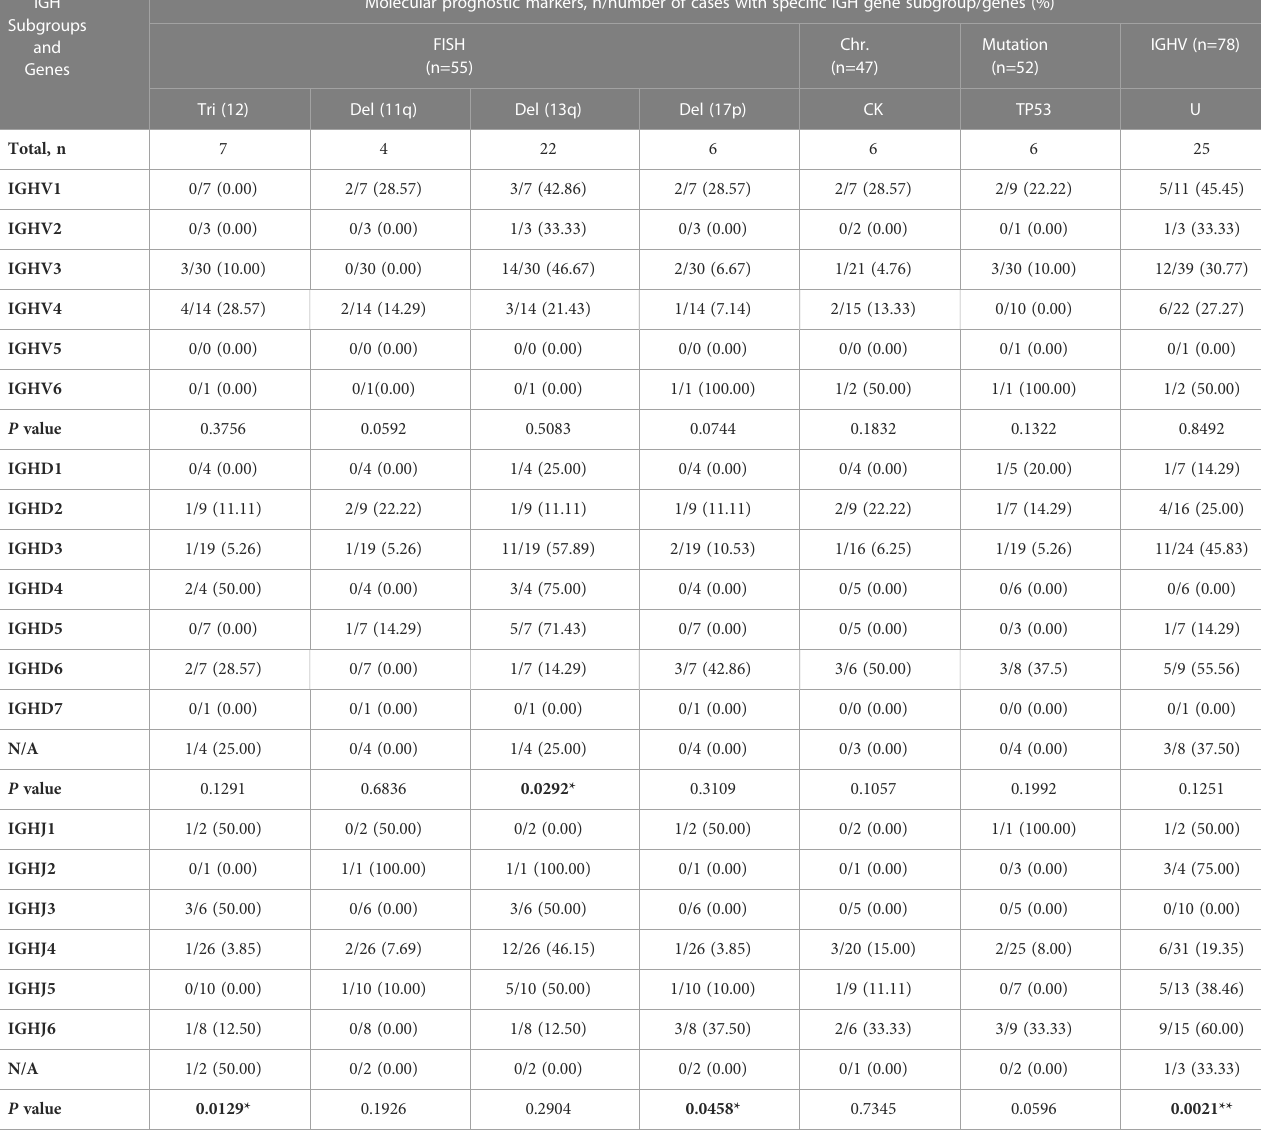
TABLE 3 Correlation of IGH subgroups/genes and molecular prognostic markers. IGH Subgroups and